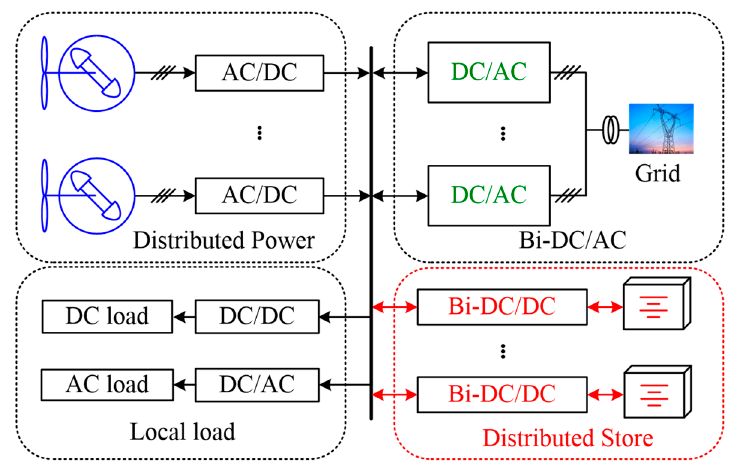
Figure 1. Typical configuration of a DC microgrid.